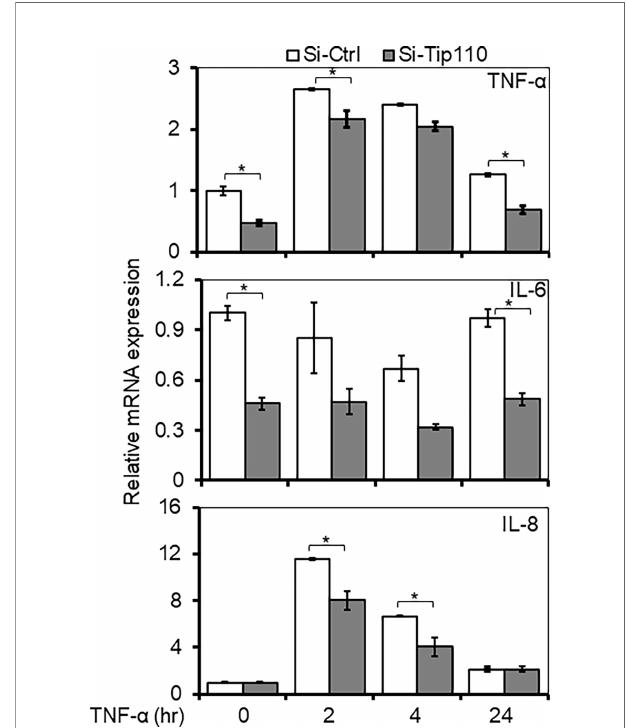
FIGURE 6 | Effects of Tip110 expression on NF- k B responsive gene expression. 293T were transfected with 50 nM of Si-Ctrl or Si-Tip110, cultured for 24 hr, treated with TNF- a (10 ng/ml) for 0, 2, 4 or 24 hr, and harvested for total RNA isolation and qRT-PCR for TNF- a , IL-6, and IL-8 mRNA expression. The relative mRNA expression was normalized to b -actin and expressed as fold increases over those in Si-Ctrl-transfected and untreated cells. The data were mean ± from triplicate samples.